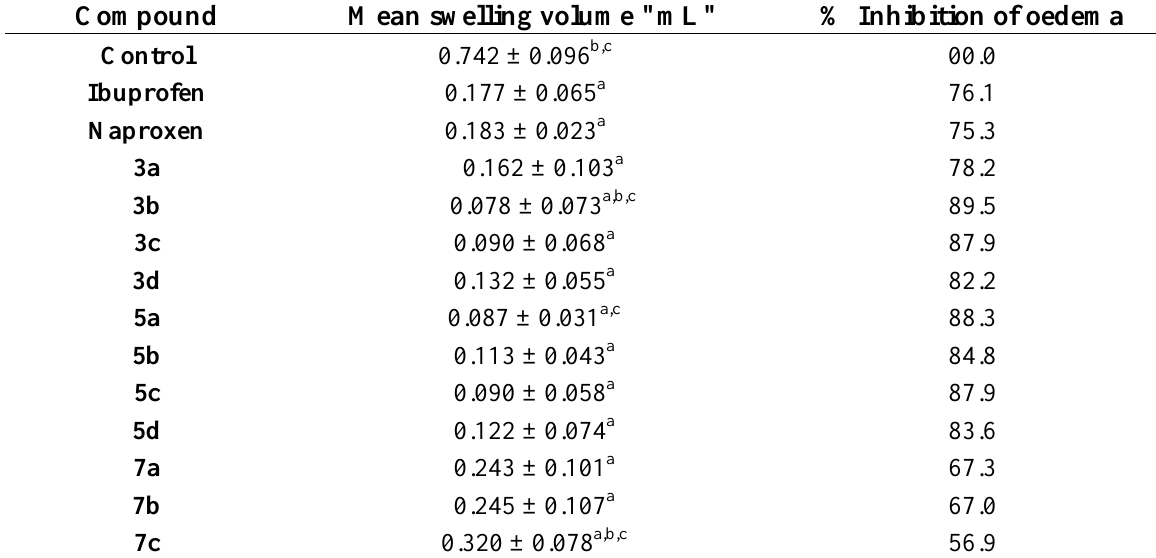
Table 1 . Anti-inflammatory Activity of the Tested Compounds Using Acute Carrageenan- Induced Paw Oedema in